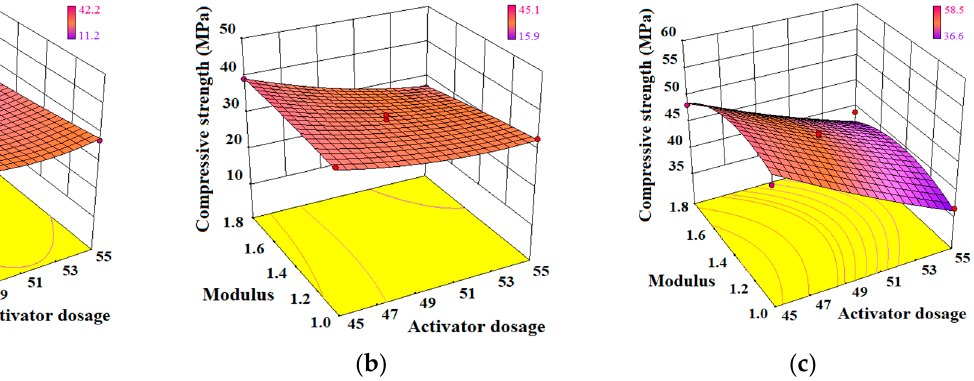
Figure 14. Effect of interaction between M and R A on the compressive strength model of AA-FASM. ( a ) 1 day. ( b ) 3 days. ( c ) 28 days.